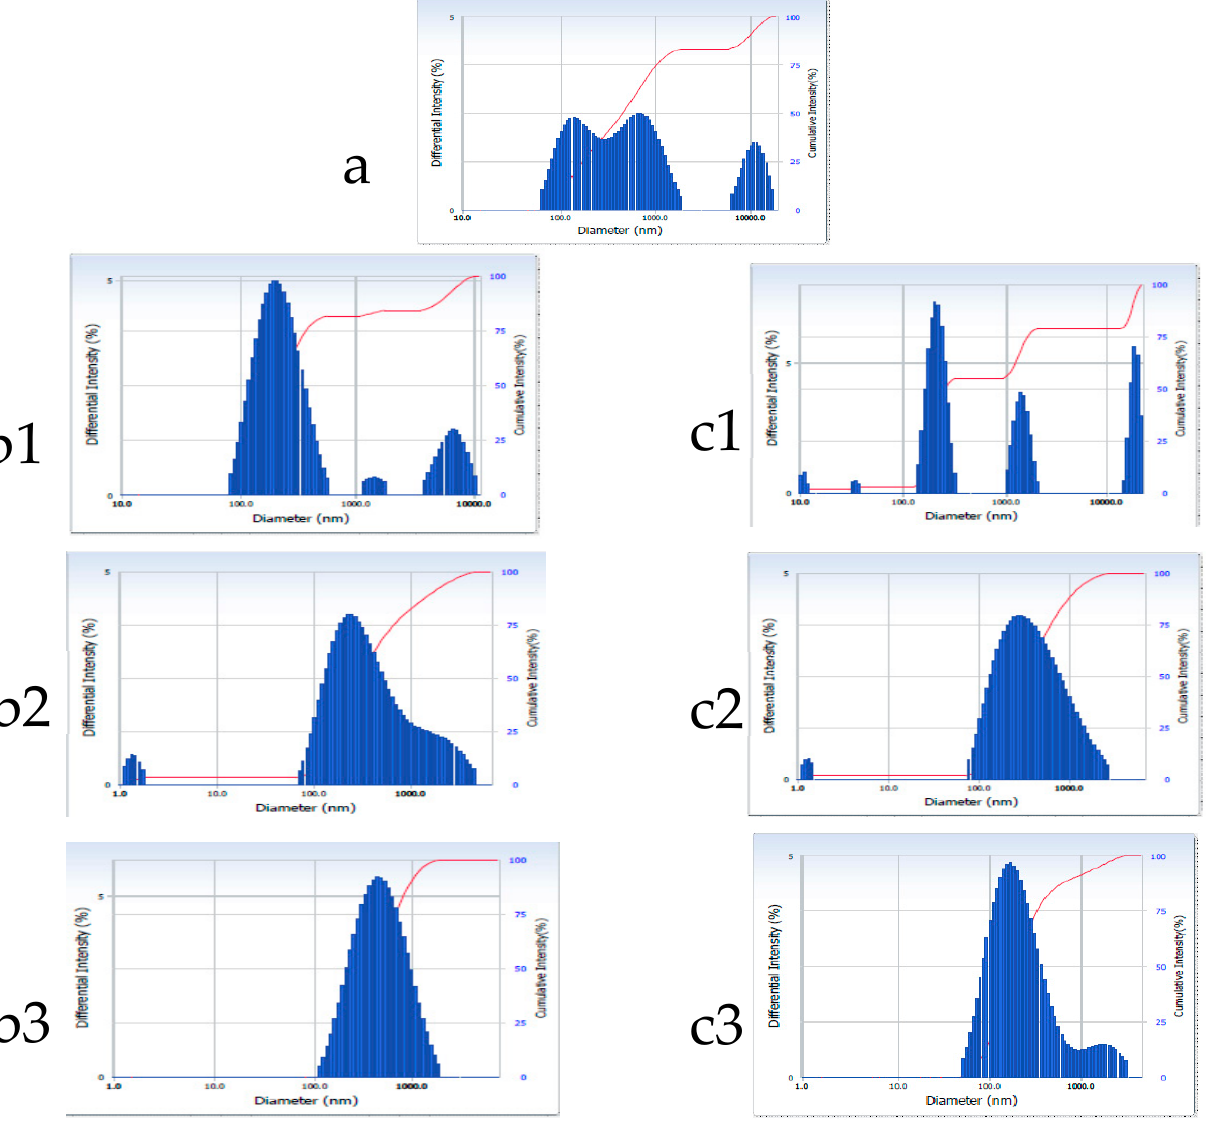
Figure 5. Particle size distribution of probiotic-loaded emulgel suppository dispersed in water (100 mL) at ( a ) zero time, ( b ) after storing at 25 °C and ( c ) 37 °C for 2 h ( b1 , c1 ), 6 h ( b2 , c2 ) and 24 h ( b3 , c3 ). SEM pictures of the cross-sectioned suppository confirmed the gel matrix (Figure 6A) interspersed with oil globules (Figure